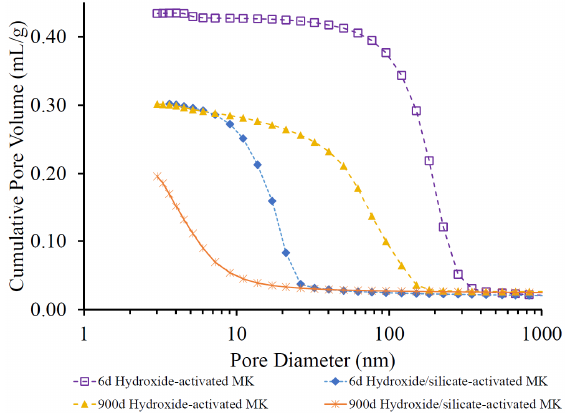
Figure 6. Mercury intrusion porosimetry cumulative pore volume curves as a function of average pore diameter for hydroxide ‐ and hydroxide/silicate ‐ activated metakaolin (MK) at 6 and 900